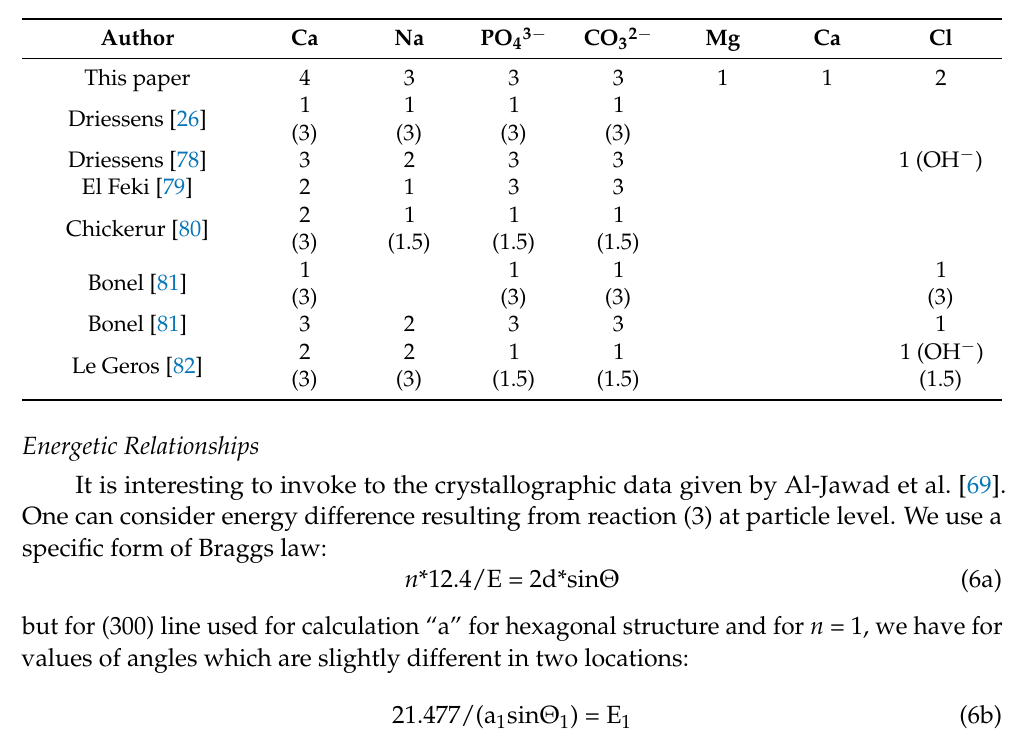
Table 3. Stoichiometric relationships in “overbuilt” enamel, compared to other known stoichiometric ratios in enamel (with recalculations of coefficients bringing them closer to our ones are given in